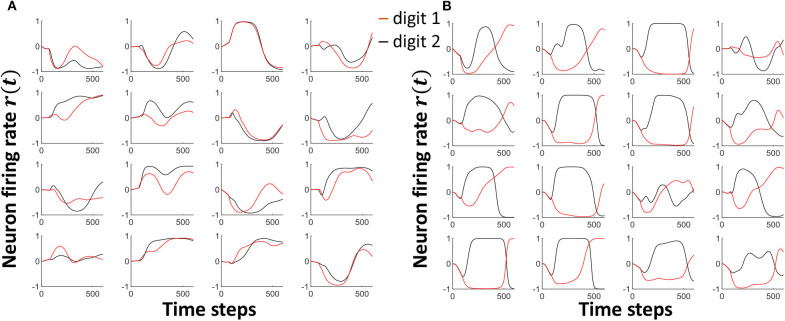
The neuron attractor dynamics of 16 randomly picked neurons for two input voice utterance classes, viz. Class1, f and Class2, f. (A) The dynamics before separation enhancement training (B) The dynamics after separation enhancement training. Note that the separation between the class attractors have significantly improved.